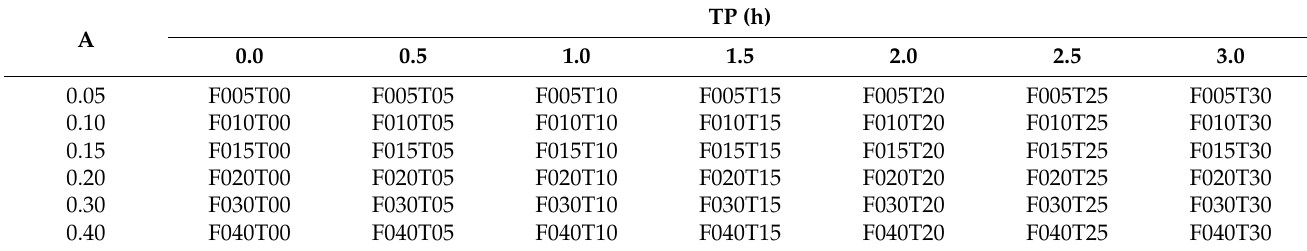
Figure 8. Cyclic load application and boundary conditions. Table 3. Description of working